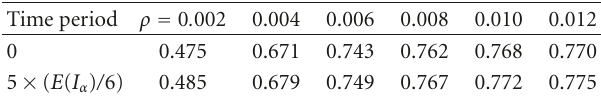
Table 2: The expected success probability of the second spectrum